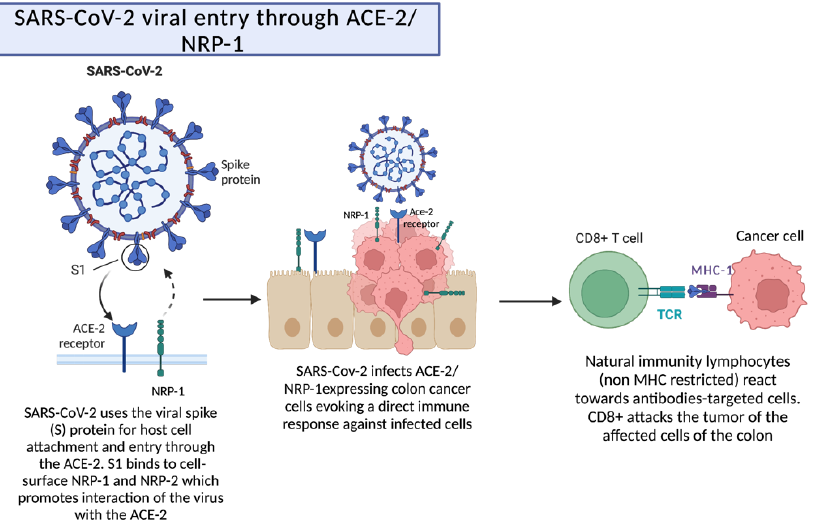
Figure 2. Reduction of a tumor by the interaction between SARS-CoV-2 and ACE-2/NRP-1 receptors. ACE-2 receptors are present in alveolar pneumocytes and in other tissues, which allows the entry and attachment of the virus. The presence of the coreceptor neuropilin-1 promotes the interaction of the virus with the ACE-2 receptor, which leads to a direct immune response. Created with BioRender.com.